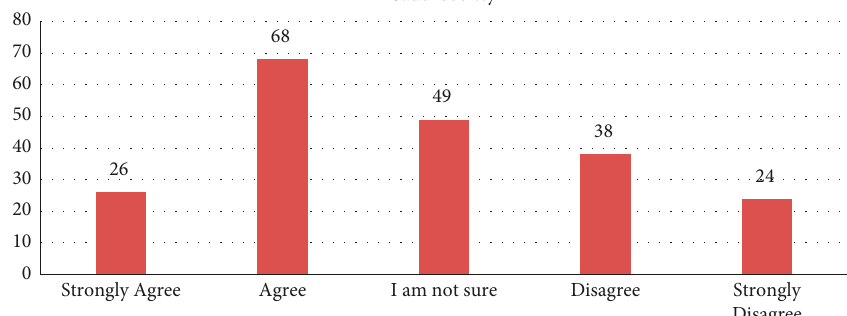
Figure 11: Participants’ responses regarding the overall cultural appropriateness of Amazon.sa.